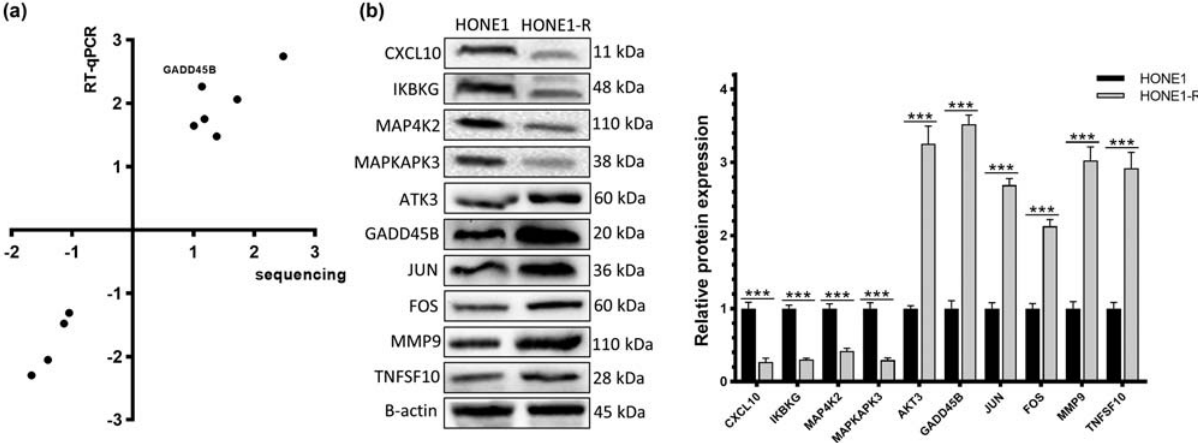
Figure 4: GADD45B is a key gene in radiation resistance of HONE1 - R cell line: ( a ) veri fi cation of gene di ff erential expression by RT - qPCR and ( b ) di ff erential protein expression determined by Western